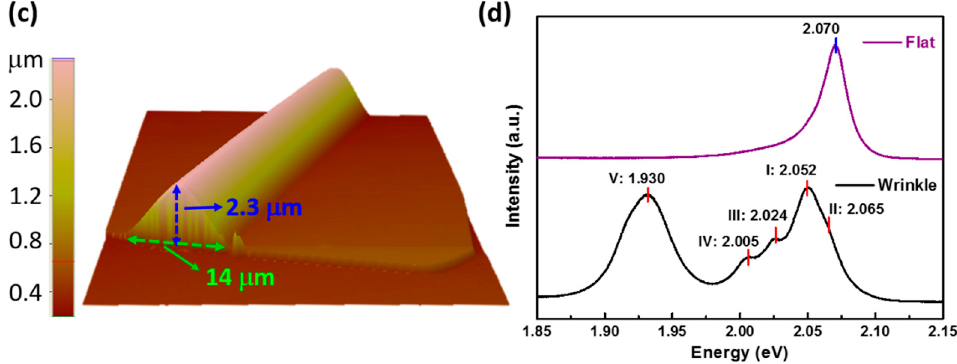
Figure 1. PL spectra from flat and wrinkled positions measured at 100 K. ( a ) Optical image of the obtained GaSe flake; ( b ) AFM image of GaSe flake; ( c ) three-dimensional AFM image of GaSe wrinkle structure; ( d ) PL spectra measured at 100 K, where the detecting positions are marked in ( a ). The peak positions are obtained by Lorenz–Gaussian fitting.